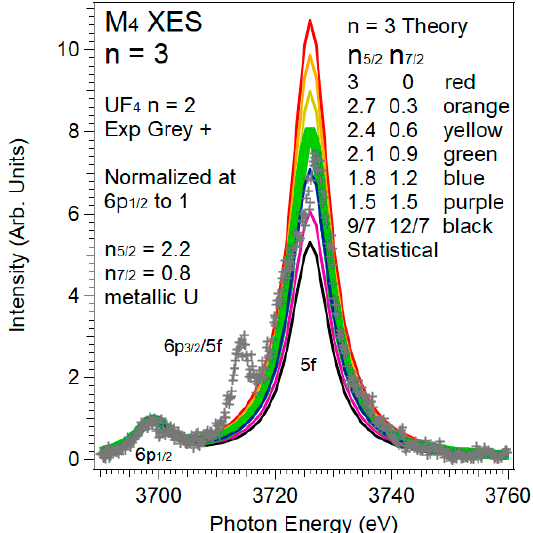
Figure 8. Shown here is the experimental M 4 XES spectrum of UF 4 and the simulated spectra for n = 3 and various values of n 5/2 . The simulation used normalized Lorentzian line shapes, with a half-width at half-max of Γ . For the 6p 1/2 : Γ = 3.5 eV. For the 5f peak, Γ = 4 eV. The 5f/6p 3/2 peak is neglected in the simulation.